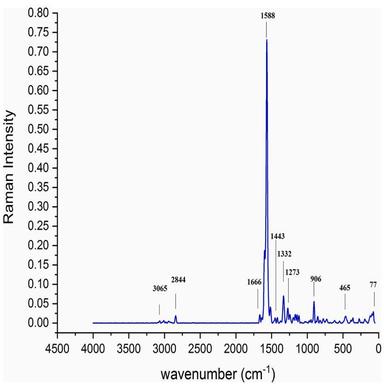
FT-RAMAN SPECTRUM OF CDMBP